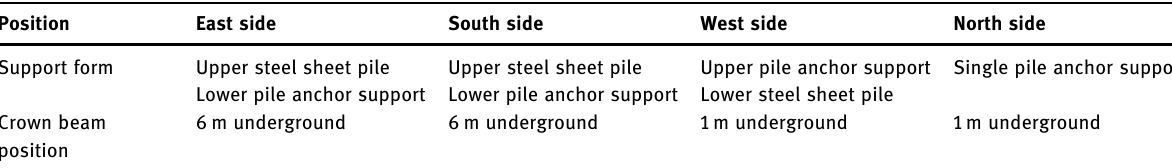
Table 3: Supporting structure of the foundation pit Position